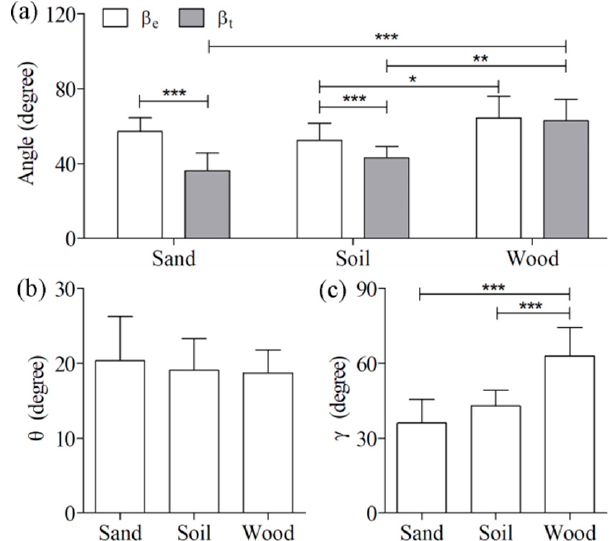
Figure 4. Comparisons of the postural features of adult locust jumps on the three ground types: ( a ) the elevation angle of locust jumps at take-off ( β t ) and the tilt angle of the line through femoral proximal and tibial distal ends just before tibial extension ( β e ); ( b ) the open angle of the femur to the central line of the body ( θ ); and ( c ) the angle between the tibial axis and the ground at take-off ( γ ). Results were reported as mean ± SD. * p < 0.05; ** p < 0.01; *** p < 0.001.